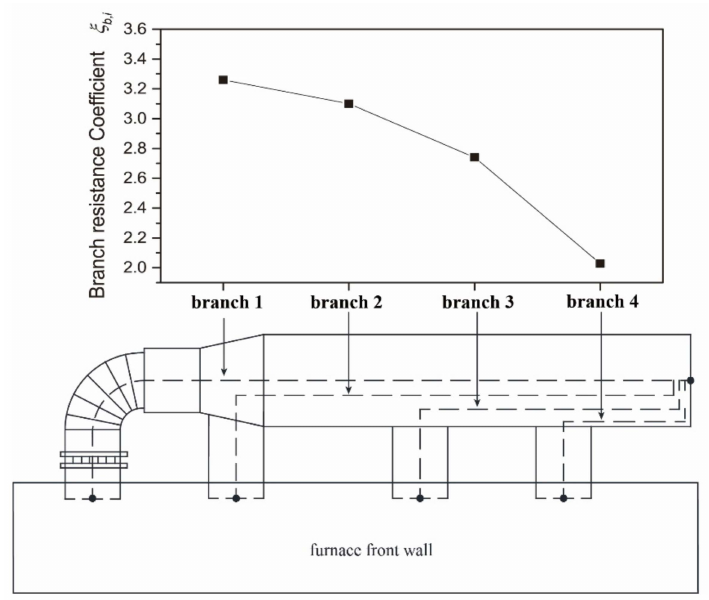
Figure 9. Branch resistance coefficient ξ b,i of C-type connection mode.